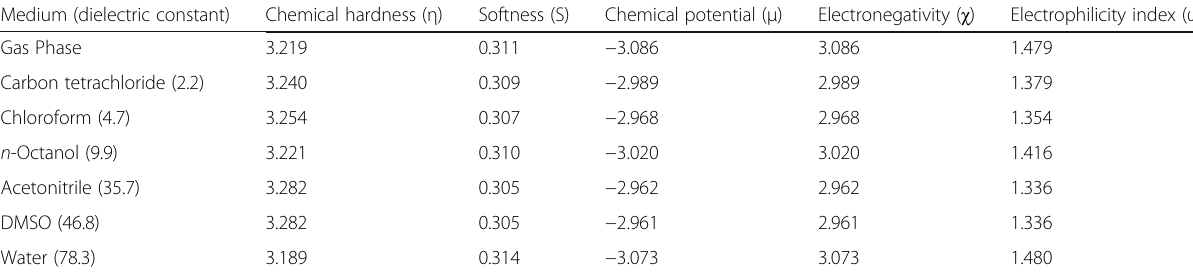
Table 6 Effect of solvent polarity on molecular properties of betulinic acid Medium (dielectric constant)